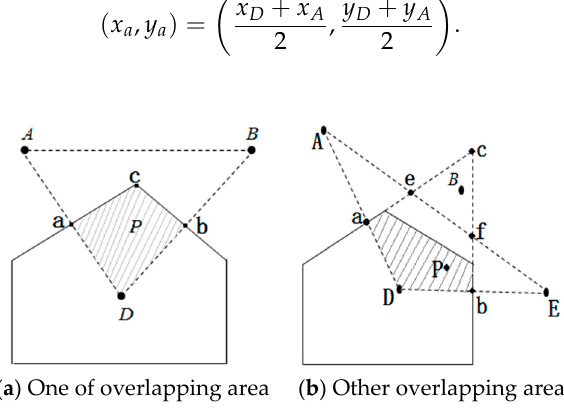
Figure 8. Determining two overlapping area.